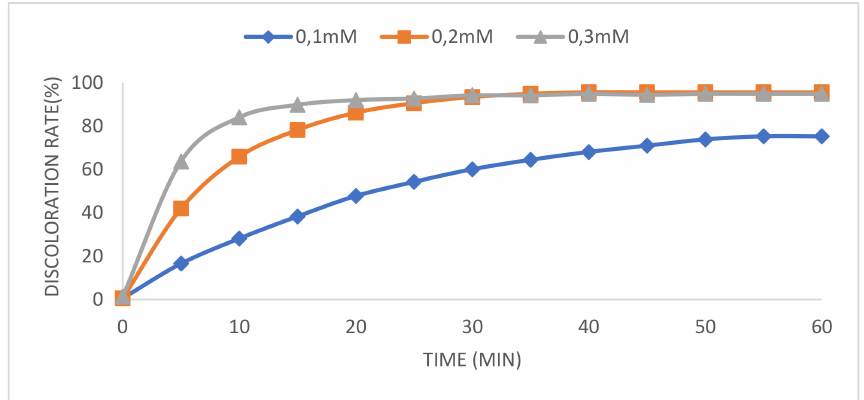
Figure 1. Effect of initial Fe 2+ concentration on discoloration rate. Reaction condition: [MO] = 20 mg/L, 50 mM Na 2 SO 4 , [I c ] = 100 mA, 8.8 mM H 2 O 2, and pH = 3, T = 30 ± 0.1 ◦ C.